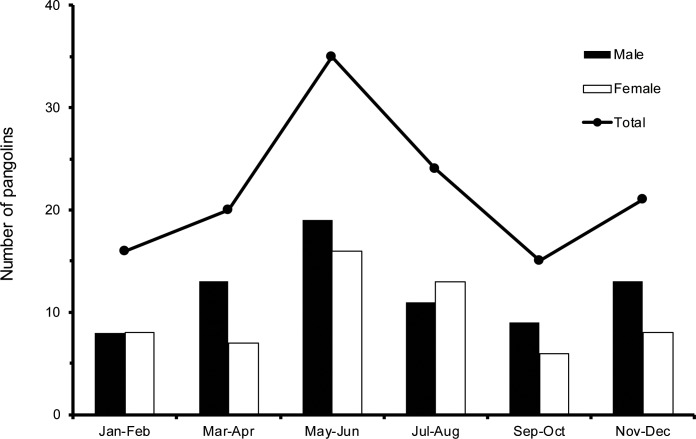
Bi-monthly totals of Taiwanese Pangolin admitted to Pingtung rescue center from 2006 to 2017.